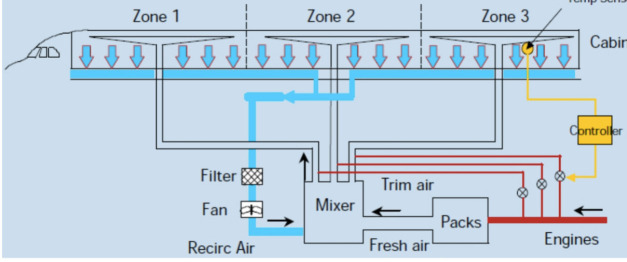
Recirculation airflow system of airbus.7